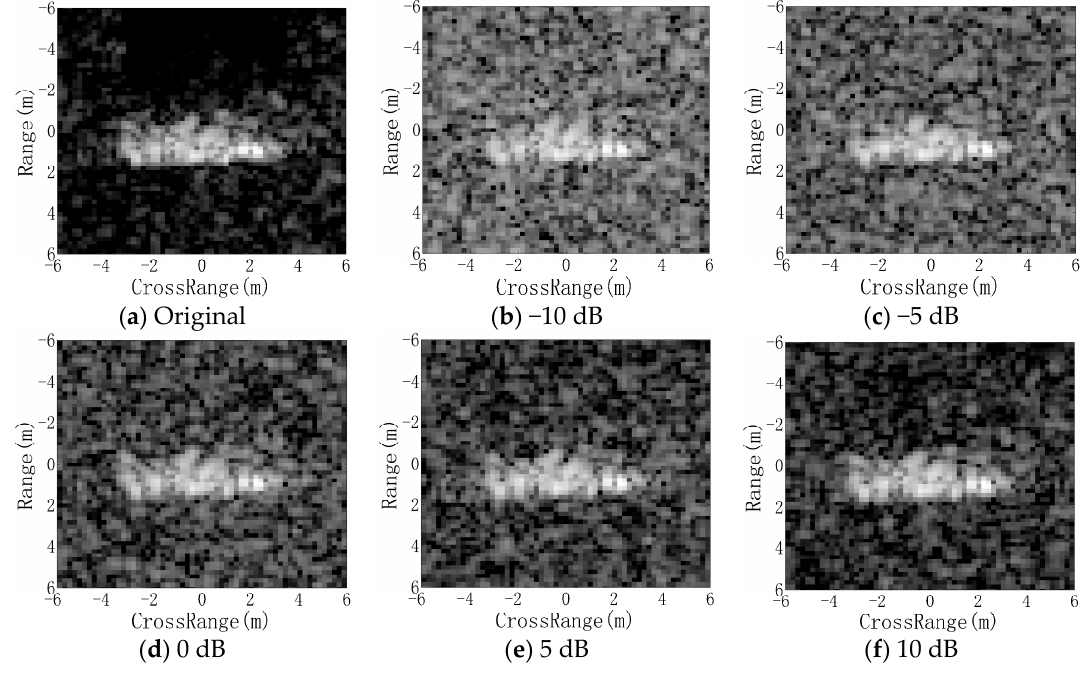
Figure 8. Noise corrupted images at different signal-to-noise ratios (SNRs).